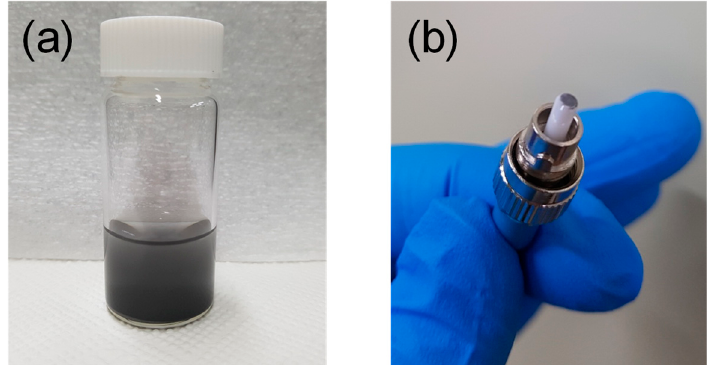
Figure 2. Real photograph of ( a ) the Bi 2 Te 3 solution and ( b ) the Bi 2 Te 3 film onto the fiber ferrule.